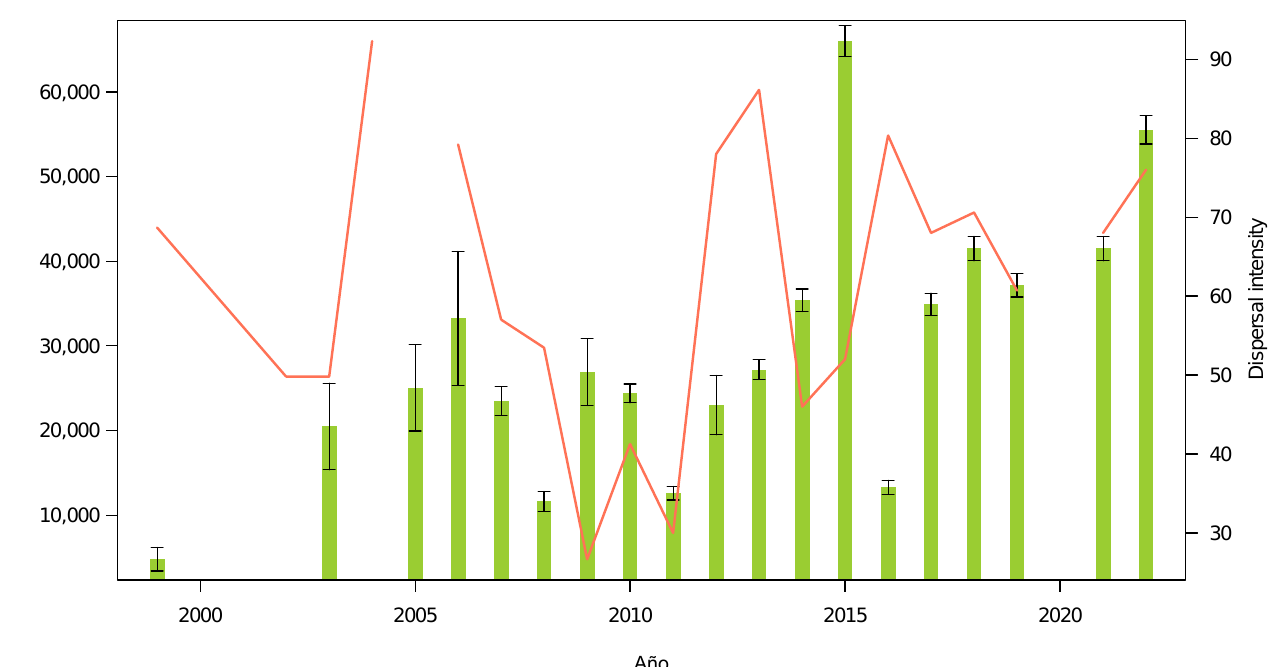
Figure 6. The relation of dispersal intensity of the dead horse arum (red line, right y -axis) and valid rainfall (blue bars, left y -axis) from 1999 to 2022 in high-density area (H.D.) of Aire Island.